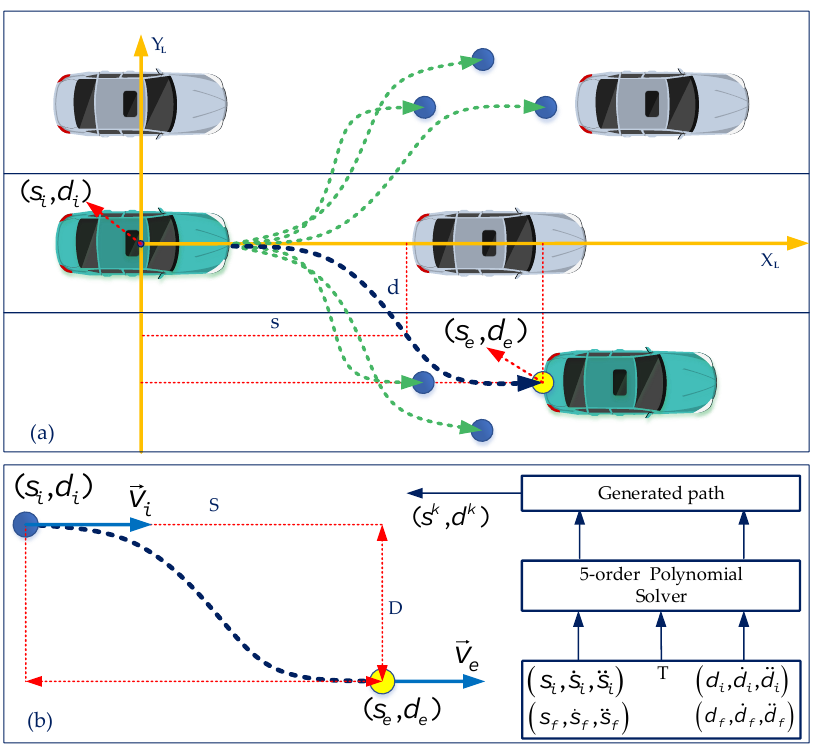
Figure 3. Jerk minimization based-trajectory generation on the local Frenet coordinates. ( a ) the lane change scenario; ( b ) jerk minimization algorithm on the temporal Frenet